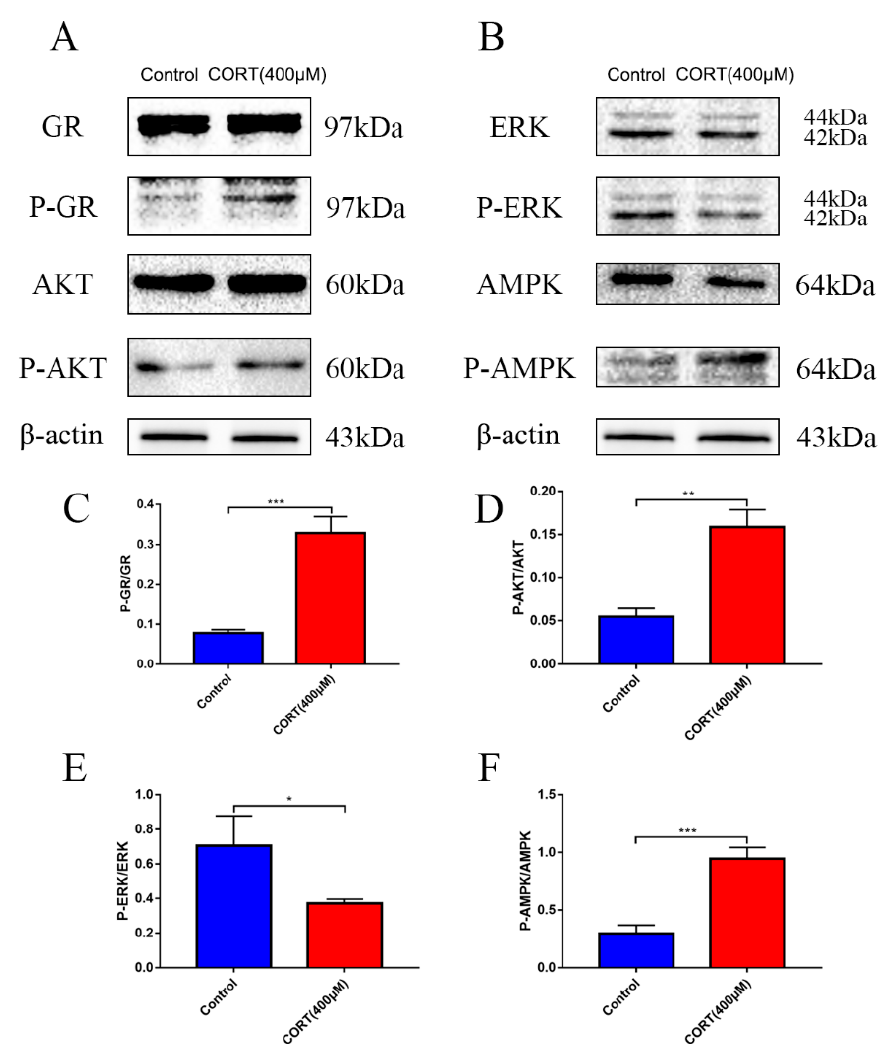
Figure 12. The relevant signaling pathway expression of key proteins in HT22 cell lysates after cortisol (CORT) treatment for 3 h as assessed by western blotting and relative density analyses ( A ) of GR, P-GR, AKT, P-AKT, ( B ) ERK, P-ERK, AMPK, P-AMPK, and β -actin expression in each group. Expression levels were quantitated by measuring band intensities using Image Lab software. The graphs indicate densitometric analyses using the expression ratios of ( C ) P-GR / GR, ( D ) P-AKT / AKT, ( E ) P-ERK / ERK, and ( F ) P-AMPK / AMPK. Data were between control (CORT 0 µ M) vs. CORT (400 µ M), and were analyzed by one-way analysis of variance. The results are expressed as the mean ± SD ( n = 3) in each independent experiment; * P < 0.05; ** P < 0.01; *** P < 0.001.